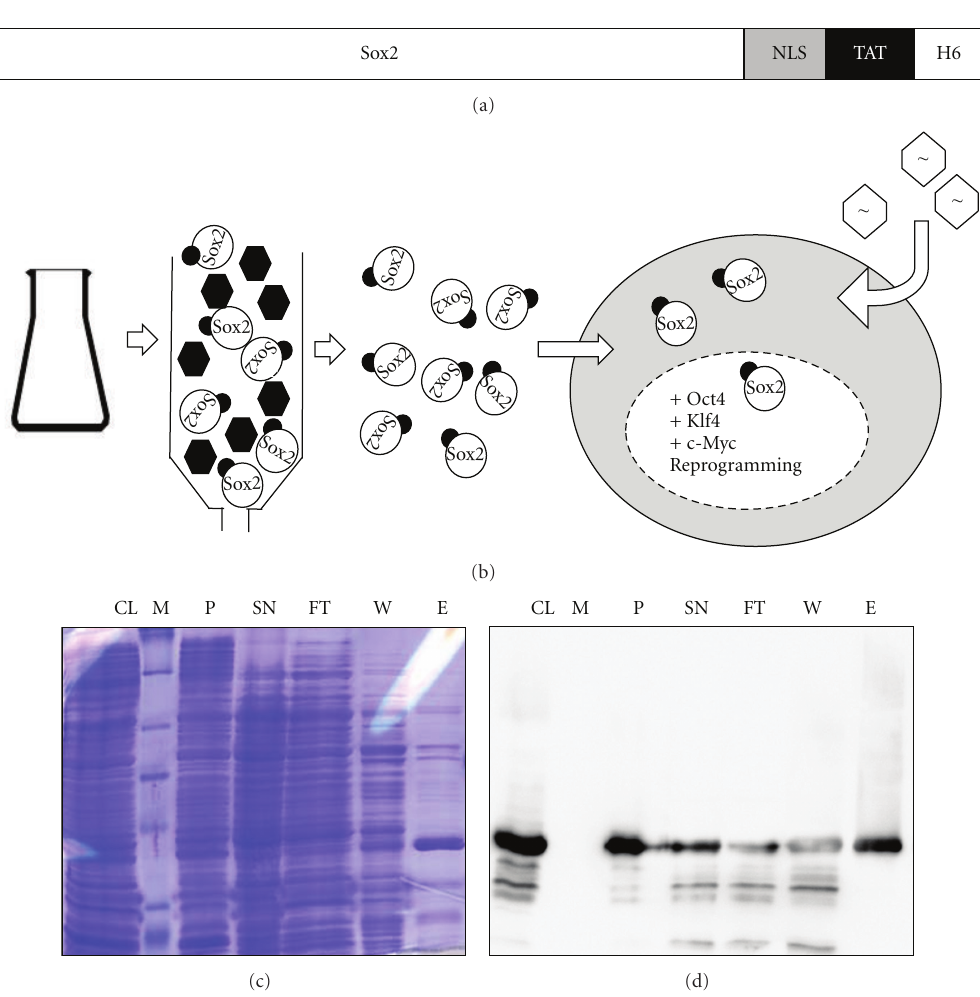
Figure 1: Purification of recombinant Sox2-TAT fusion protein and reprogramming setup. (a) The recombinant cell-permeant Sox2 fusion protein [22] consists of the full-length Sox2 protein and a carboxy-terminally fused sequence of tags consisting of a nuclear localization sequence (NLS), cell-penetrating peptide TAT, and a histidine-tag (H6) for single-step purification. (b) Schematic representation of the expression and purification procedure and the reprogramming setup used in this study. After expression in E. coli , Sox2-TAT-containing cell lysates are subjected to a ffi nity column chromatography employing Ni-NTA resin. Purified recombinant Sox2-TAT protein is eluted from the column and its reprogramming competency assessed in combination with retroviruses encoding Oct4, Klf-4, and c-Myc. (c, d) Biochemical analysis of Sox2-TAT purification from E. coli . The following fractions were subjected to SDS-PAGE analysis: crude lysate (CL), marker (M), pellet (P), supernatant (SN), flow-through (FT), washing bu ff er (W), and elution fraction (E). SDS gels were either stained using Coomassie (c) or used for preparation of an immunoblot using anti-Sox2-specific antibody